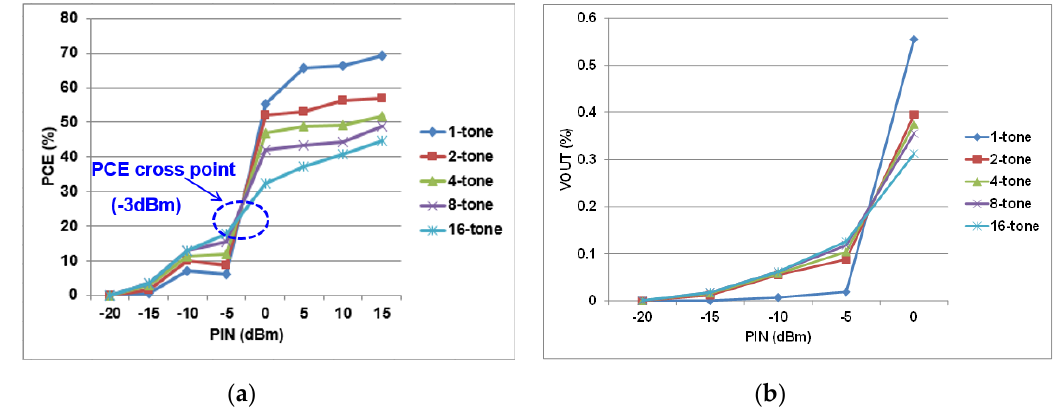
Figure 10. Measurement environment of 900 MHz SWIPT system.